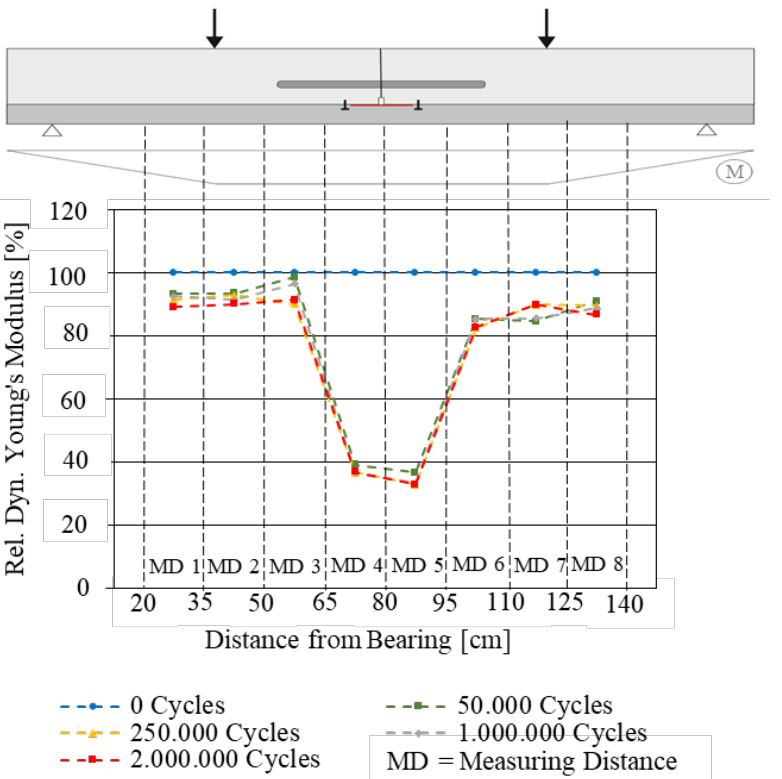
Figure 5. Example of the development of the relative cyclic Young’s modulus over 2 million load cycles on a 30 mm thick cracked CTRC overlay (2 reinforcement layers, with bond breaker) as a indicator for